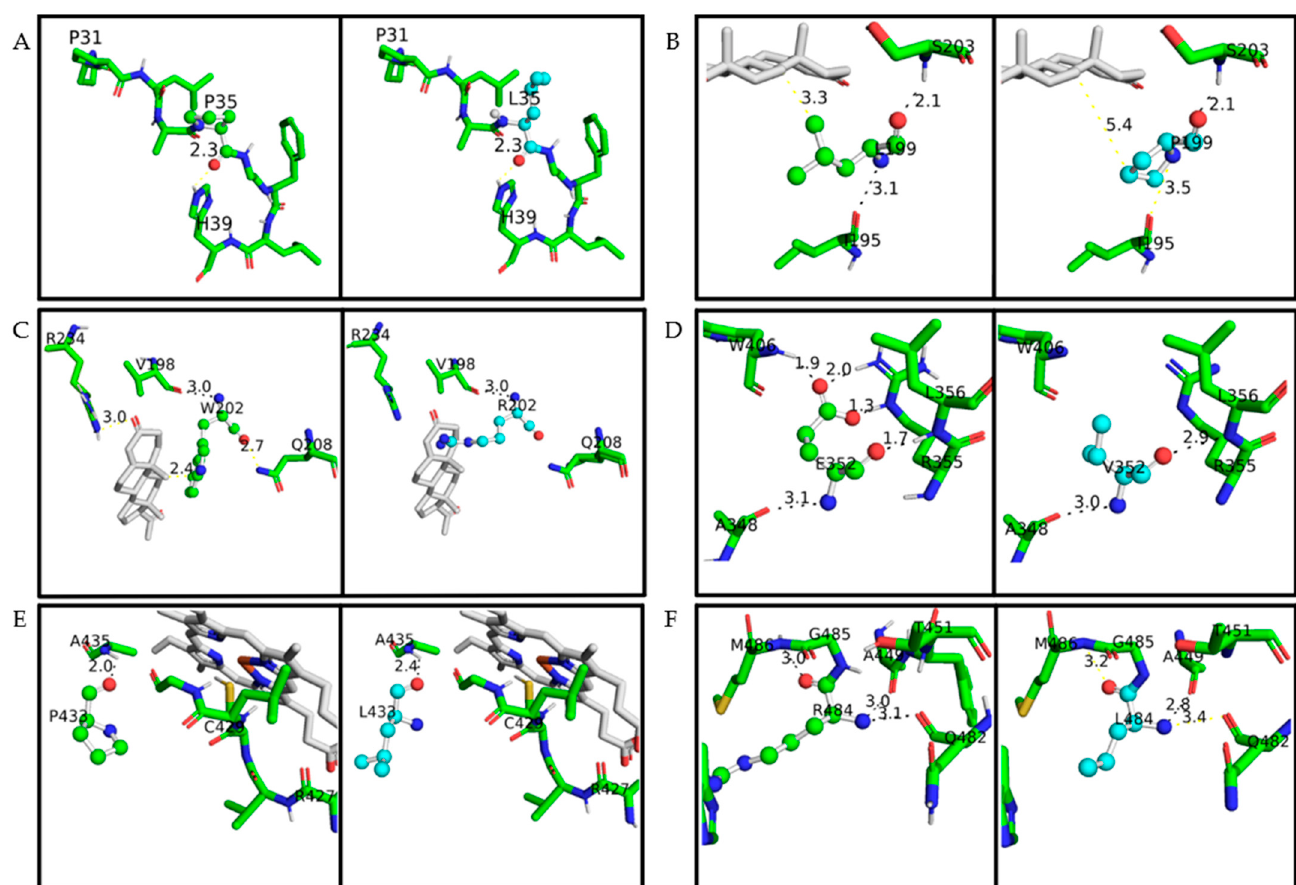
Figure 3. A closeup of the amino acid studied on the CYP21A2 structure. The protein structure is based on PDB ID 4Y8W. Wild-type amino acids are colored in green and mutated in cyan; in both of them, oxygen is red, nitrogen is blue, and sulfur is yellow. The distance measured between the main amino acids connections is with less than 4 Å. Hydrogen bonds are represented with black lines, while any other measurement between atoms is represented with yellow lines. Progesterone and heme are colored grey. ( A ) p.P35 and p.P35L, ( B ) p.L199 and p.L199P, ( C ) p.W202 and p.W202R, ( D ) p.E352 and p.E352V, ( E ) p.P433 and p.P433L, ( F ) p.R484 and